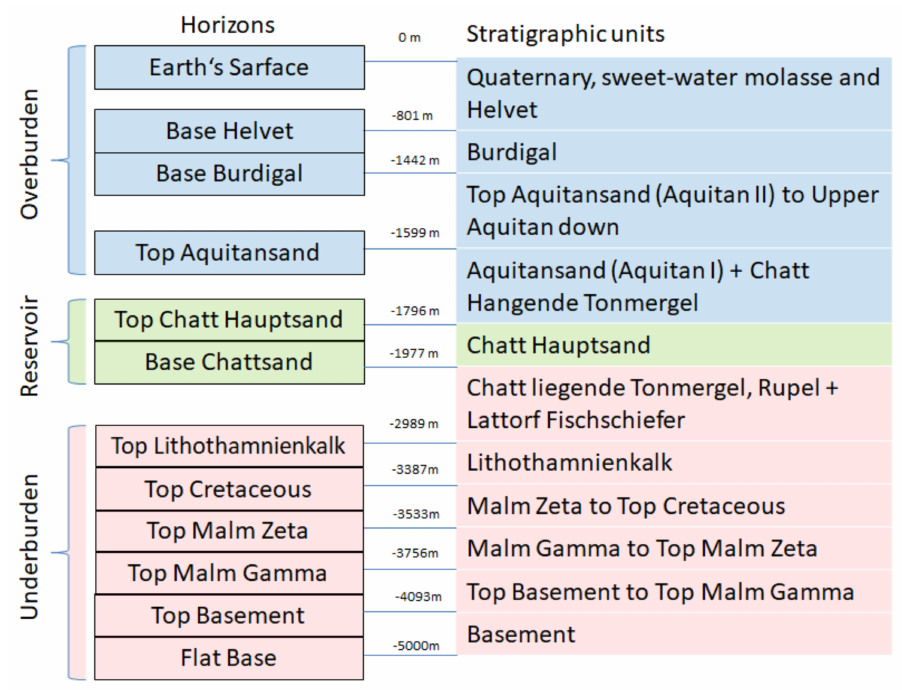
Figure 7. Model horizons along with intervening lithostratigraphic units used to build up the 3D mechanical earth modeling (MEM) down to a depth of 5